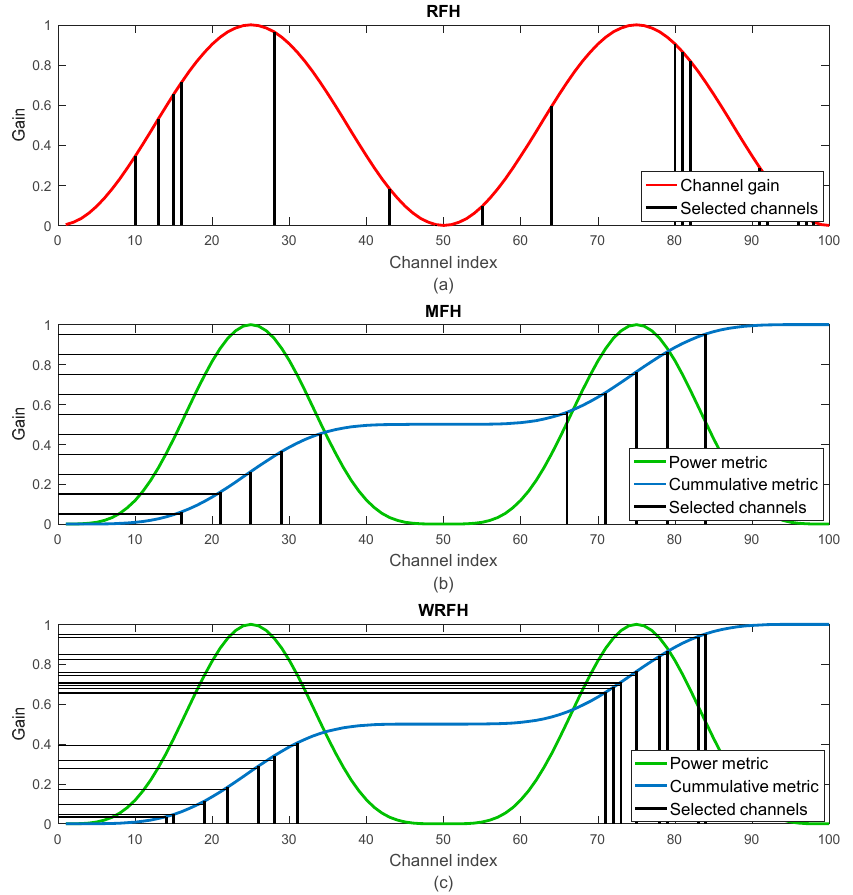
Figure 11. Comparison of channel selection between different frequency hopping techniques: ( a ) Random Frequency Hopping (RFH); ( b ) Matched Frequency Hopping (MFH); ( c ) Weighted Random Frequency Hopping (WRFH). In the RFH and MFH cases, horizontal lines are equally spaced while in the WRFH case, horizontal lines are randomly spaced.